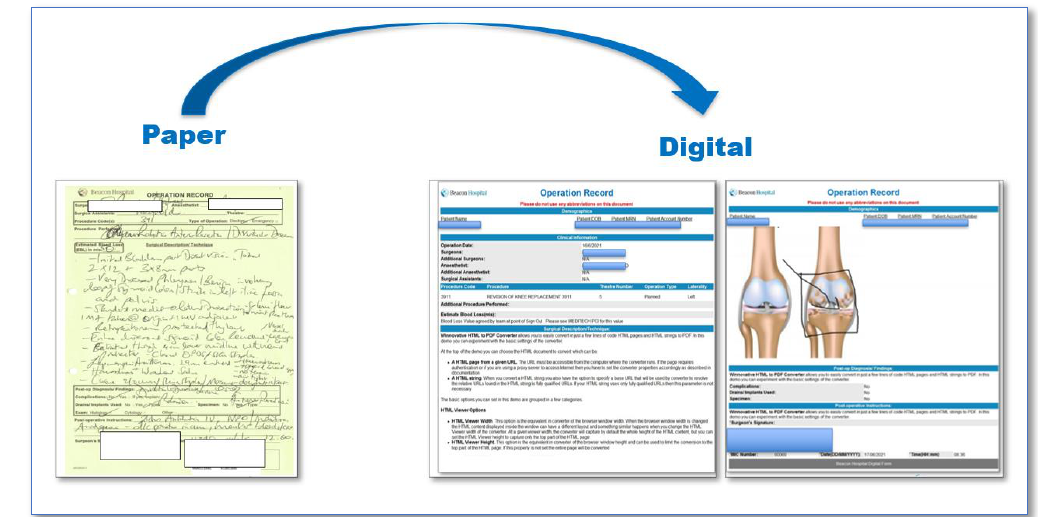
Figure 9. The newly designed form .